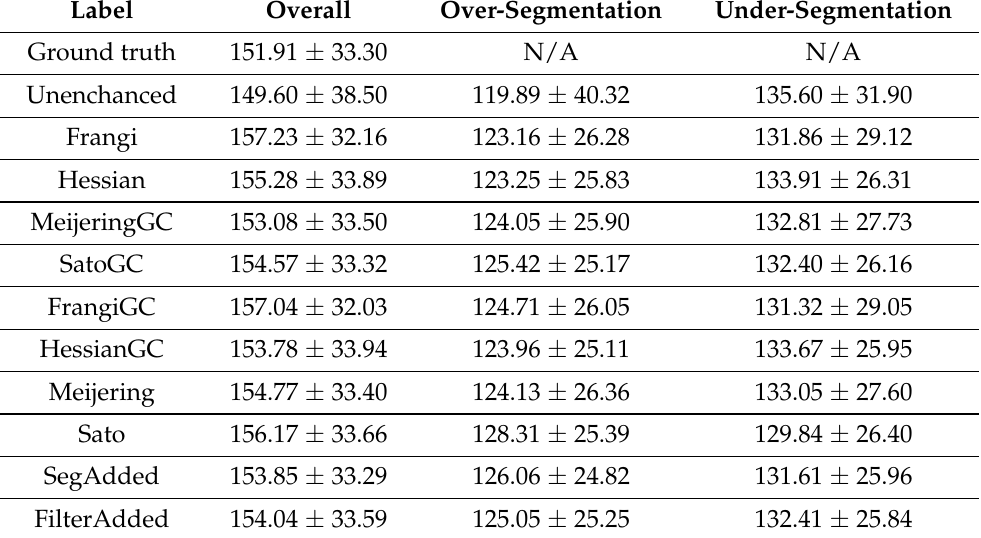
Table 2. Average overall HU for test data evaluation with over- and under-segmentation.